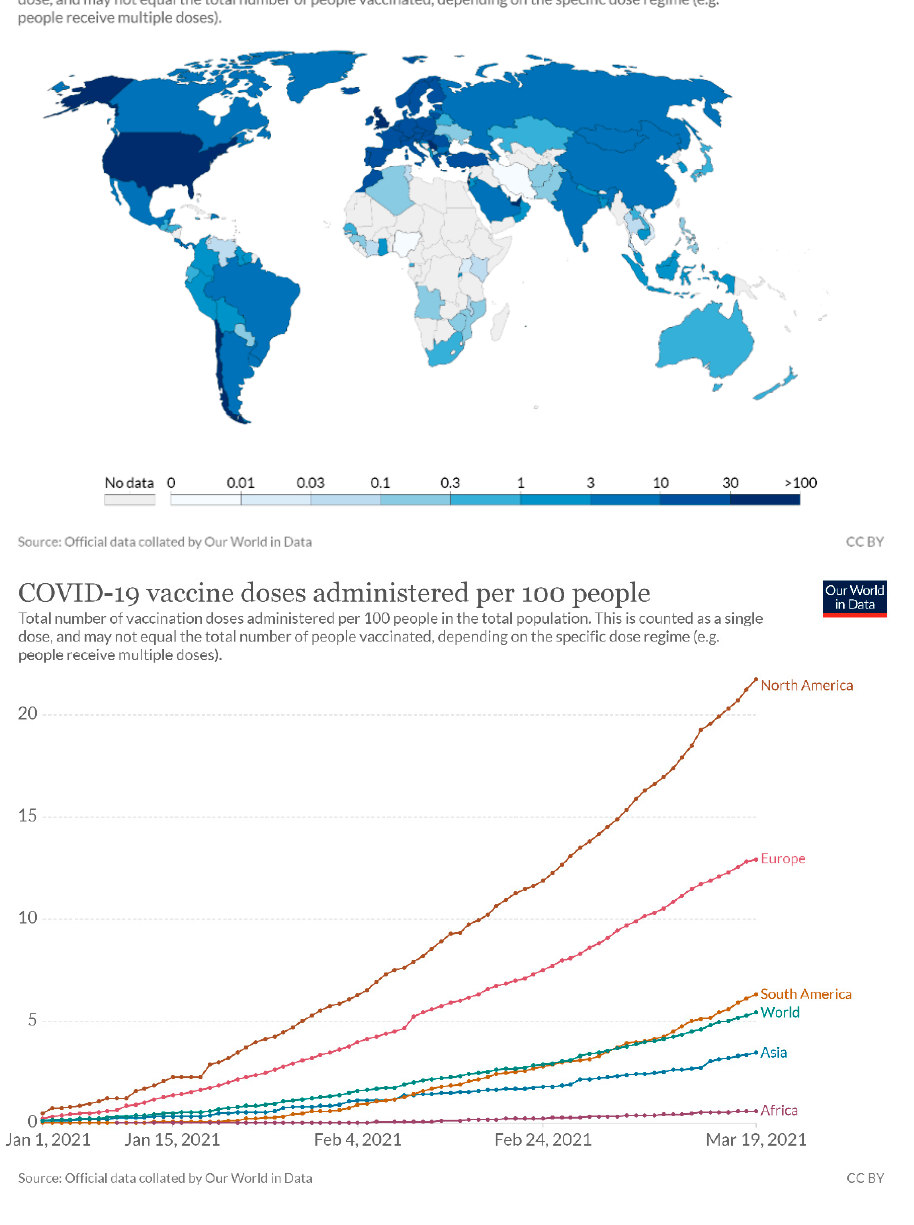
Figure 7. The rates of COVID-19 vaccine administration in different countries and continents up to 19 March 2021 (https://ourworldindata.org/covid-vaccinations). 8. The Three-Tier System of Dental Services Reinstallation in Regions Where Testing System Is Not